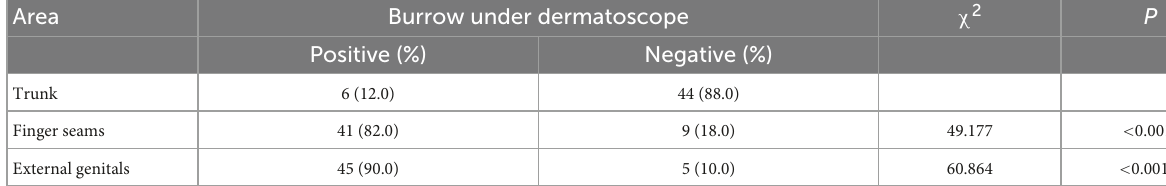
TABLE 2 The regional distribution of the characteristic dermoscopic manifestations of 50 confirmed scabies patients.